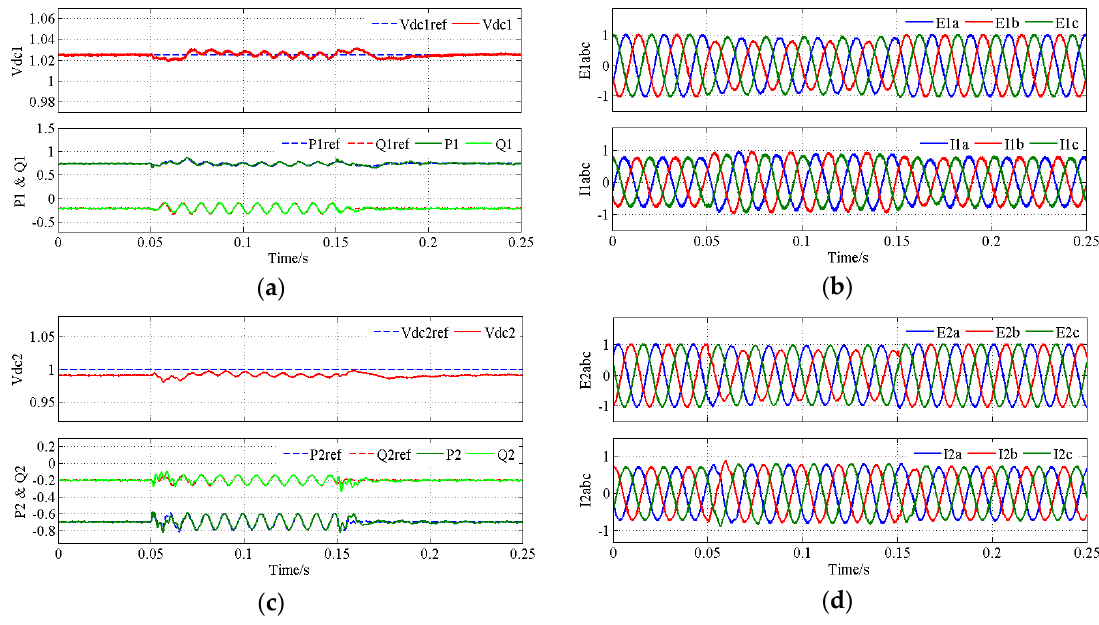
Figure 7. System response to grid voltage unbalance disturbance in the presence of parameter inaccuracy and frequency deviation by the proposed IRSMC DPC controller. ( a ) dc bus voltage, active and reactive power for CS1; ( b ) grid voltage and ac current for CS1; ( c ) dc bus voltage, active and reactive power for CS2; ( d ) grid voltage and ac current for CS2.